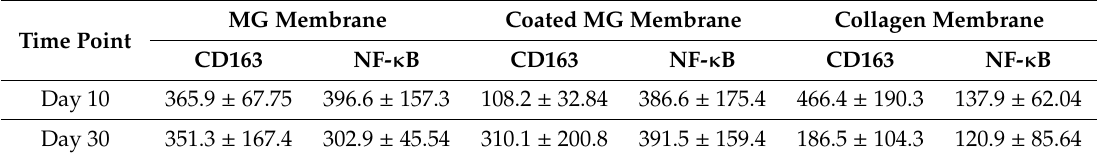
Table 1. Occurrence of pro- and anti-inflammatory macrophages in the three study groups (cells / mm 2 ).